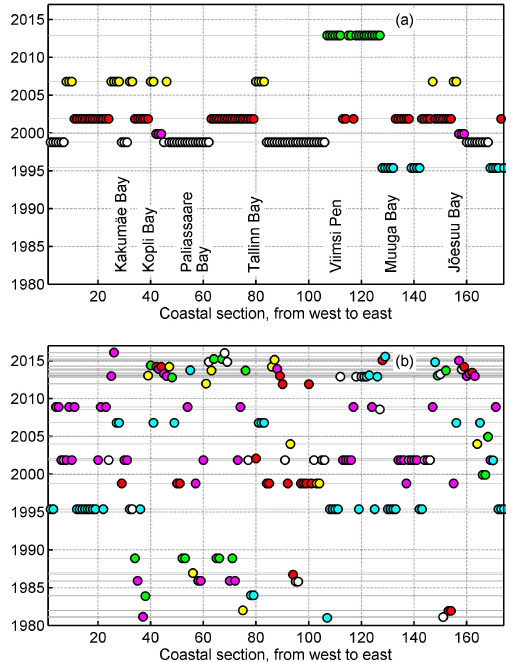
Figure 6. (a) Six storms that caused the highest waves in differ- ent coastal sections of the study area in January 1981–May 2016. Notice the cluster of green circles along the eastern coast of Vi- imsi Peninsula in an autumn storm of 2013. (b) There were 58 storms that caused the highest wave set-up in these sections in Jan- uary 1981–May 2016. The set-up heights are evaluated similarly to the procedure in Pindsoo and Soomere (2015) using only waves ap- proaching at angles of ± 15 ◦ with respect to shore normal. Colours vary cyclically in time and correspond to different storms in single